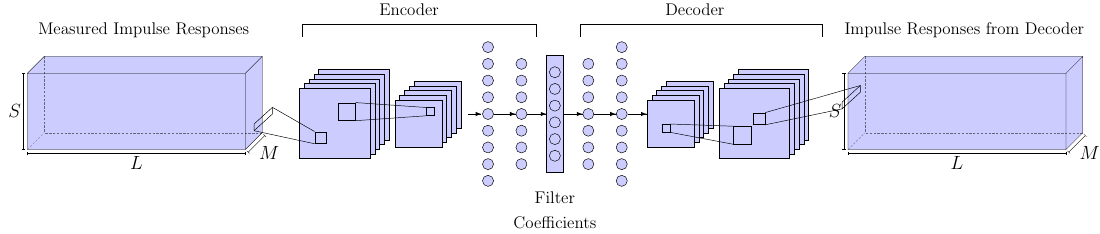
Figure 4. Scheme of the proposed method using